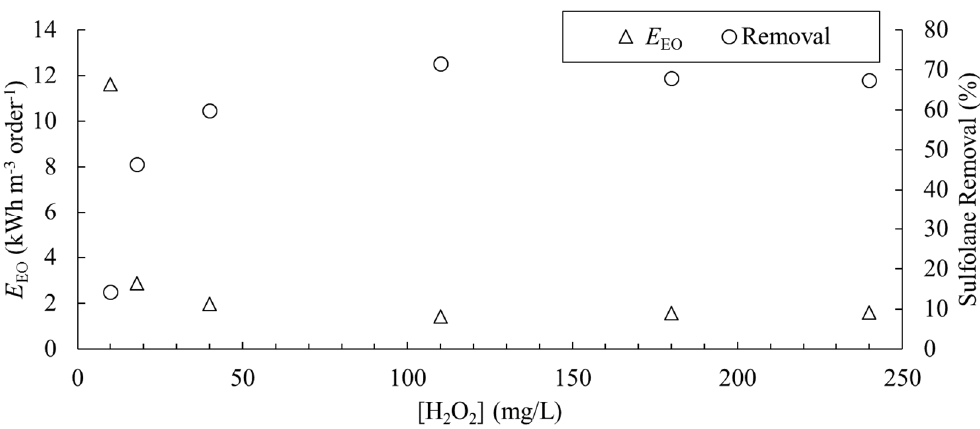
Figure 5. E EO and sulfolane removal versus the H 2 O 2 concentration in Water II, [sulfolane] = 9.5 mg/L, Q = 46 L/min.